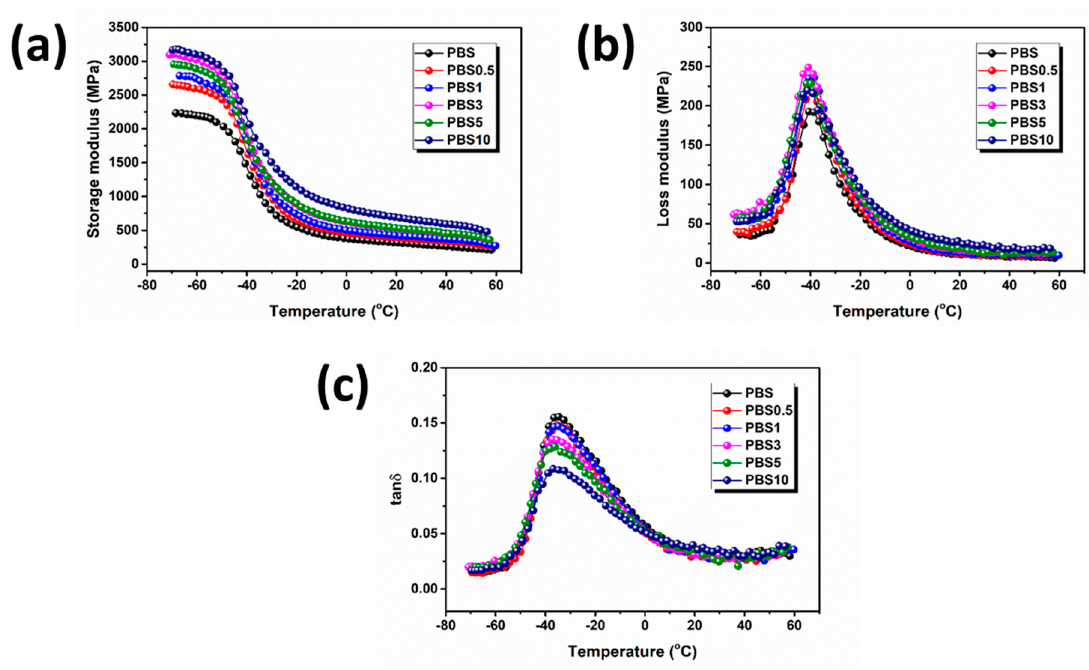
Figure 5. Dynamic mechanical properties of PBS/CB nanocomposites: ( a ) storage modulus ( E ’); ( b ) loss modulus ( E ’’); ( c ) tan δ .